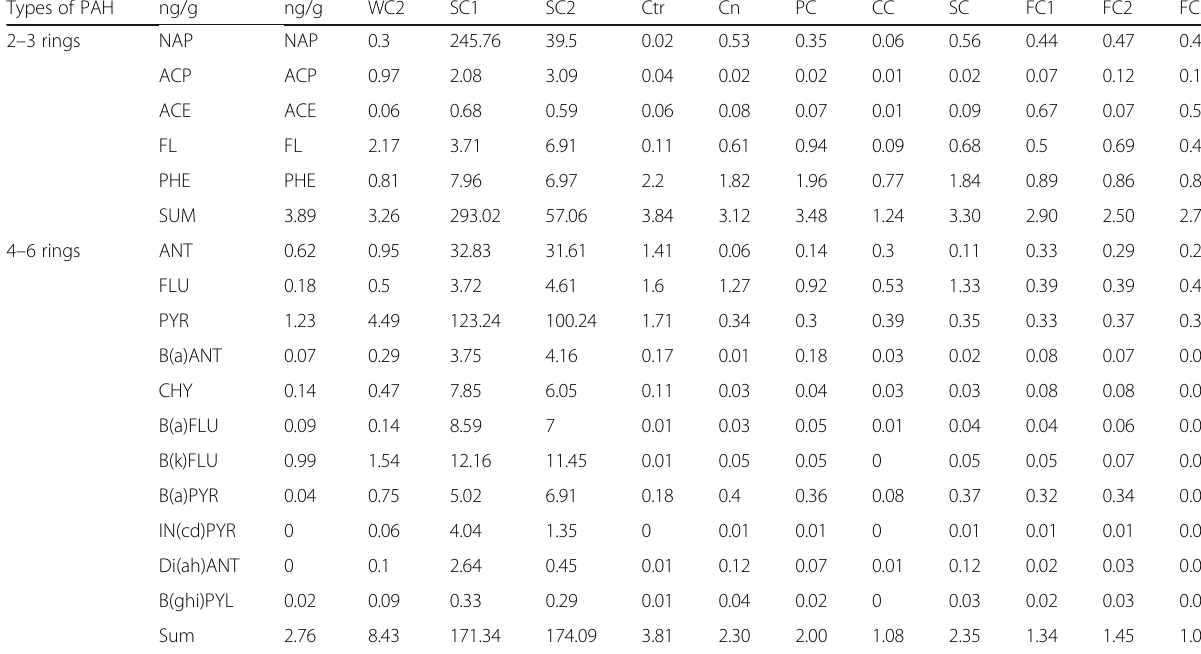
Table 2 Bioaccumulation of PAHs in water, sediment and selected aquatic organisms in Ilase area of Snake Island Types of